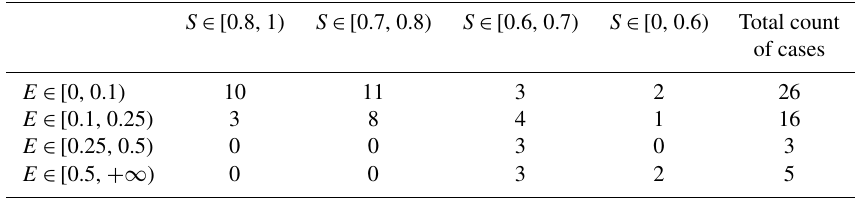
Table 4. Relationship between E and the similarity value ( S ) of the solution case to the evaluation case.